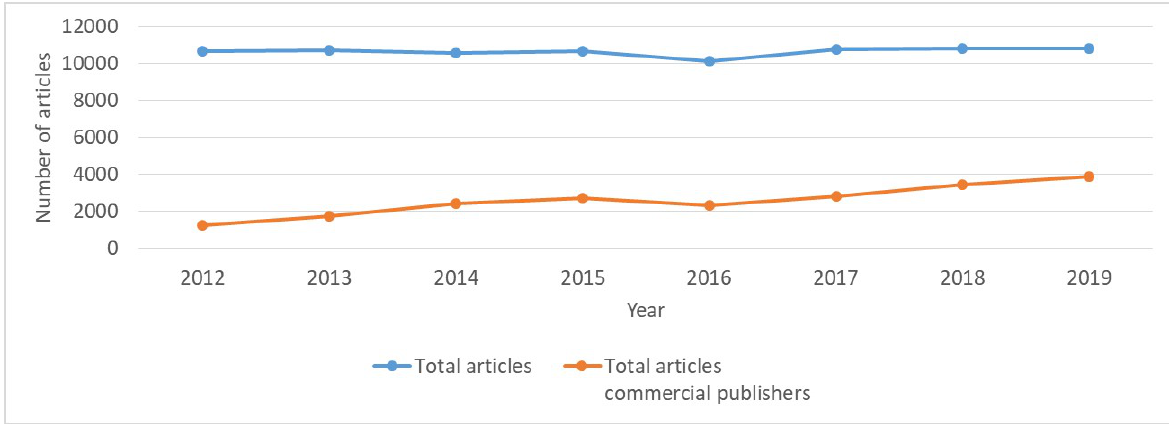
Figure 7. Total number of articles published from 2012 to 2019 (Web of Science 2012-2019) and total number of articles published from journals maintained by commercial publisher in the same period. (Source: the